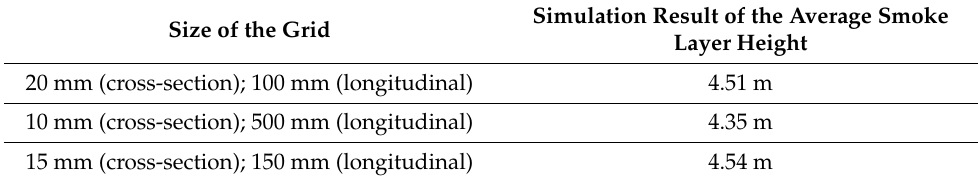
Table 4. The results of grid sensitivity test.